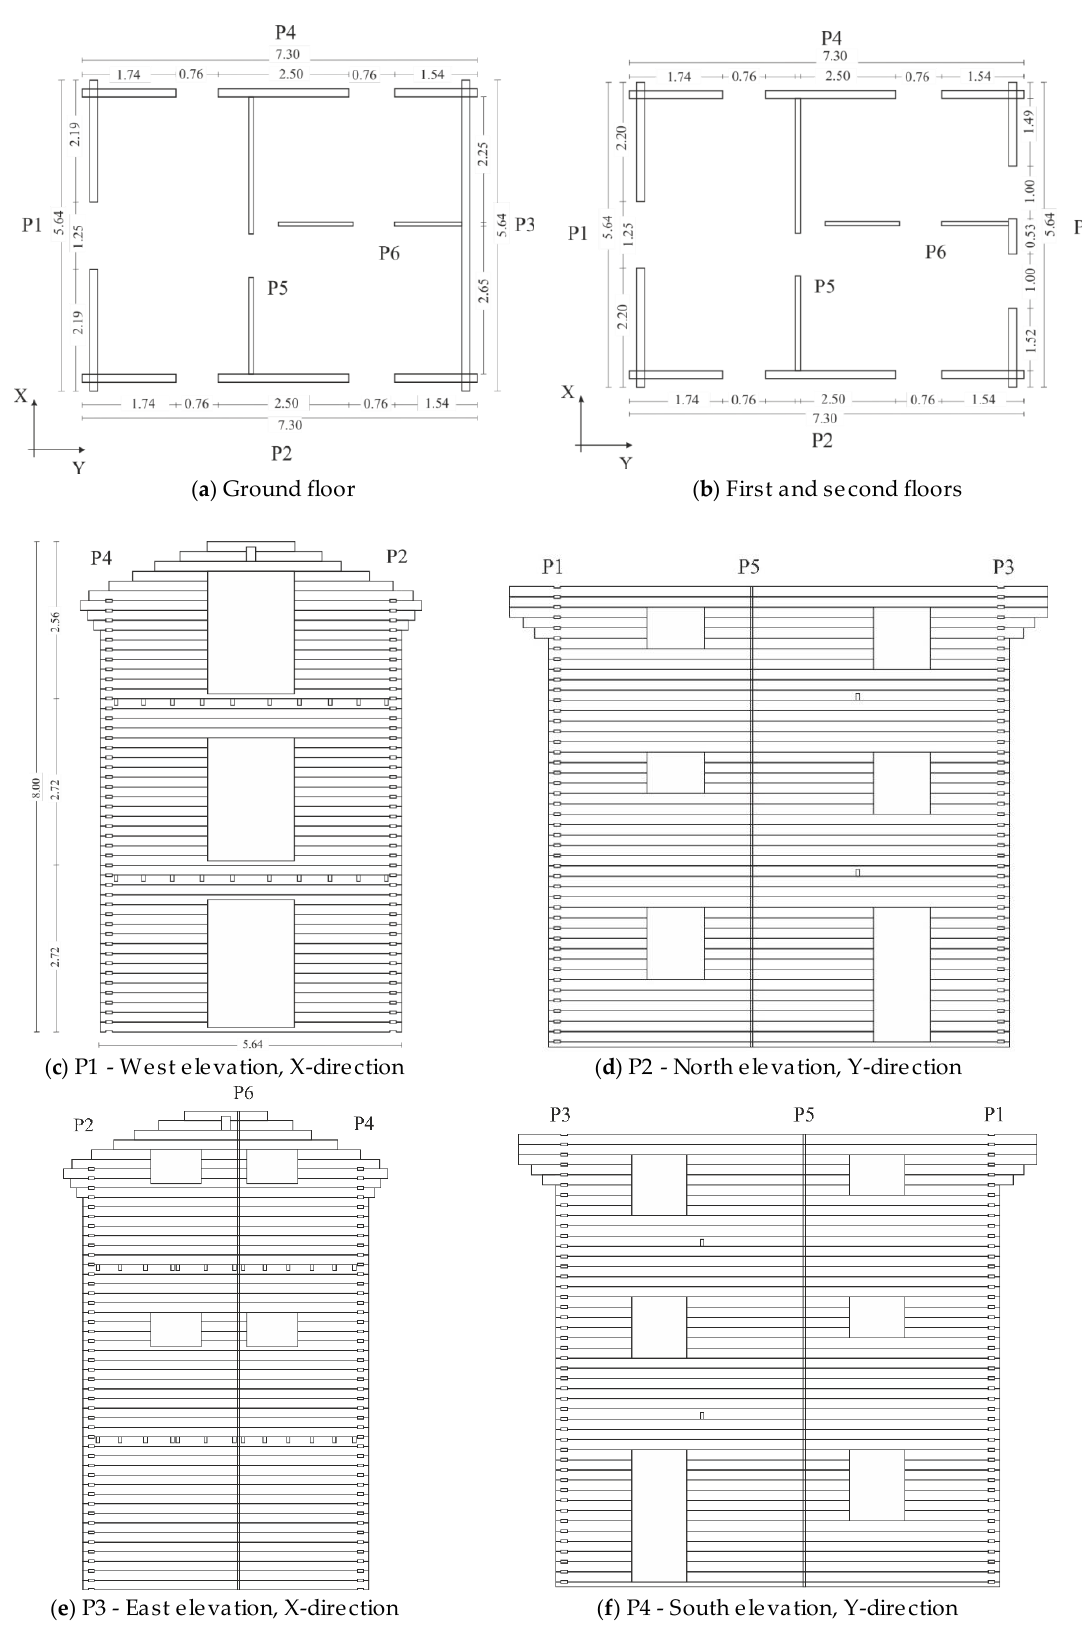
Figure 4. Case-study system: ( a , b ) floor views and ( c )–( f ) elevation views (dimensions in m).